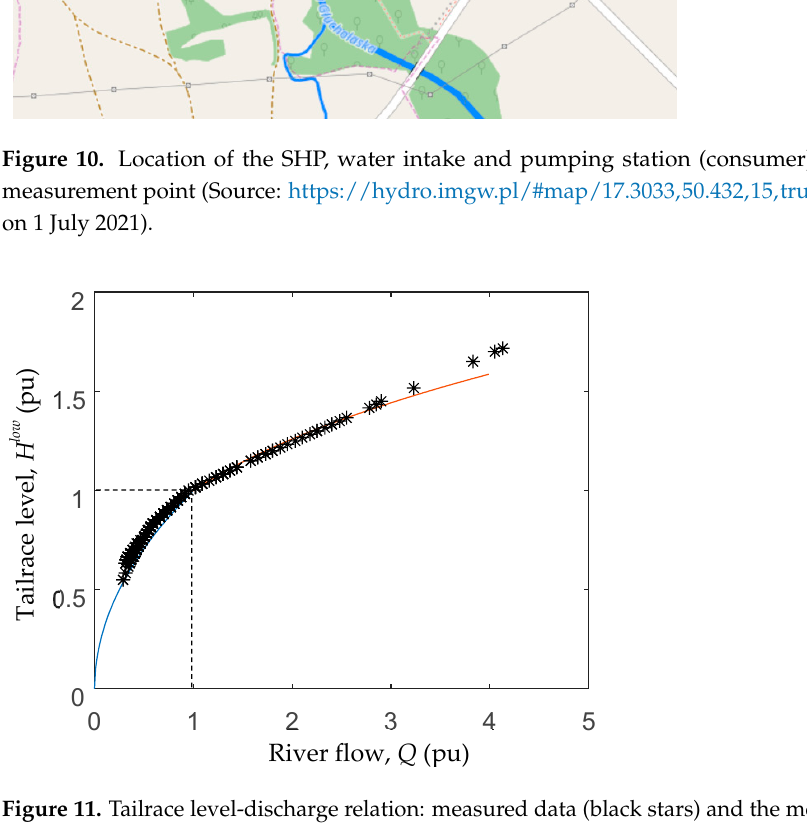
Figure 11. Tailrace level-discharge relation: measured data (black stars) and the model curve (blue— normal, red—flood level) based on Formula (4).